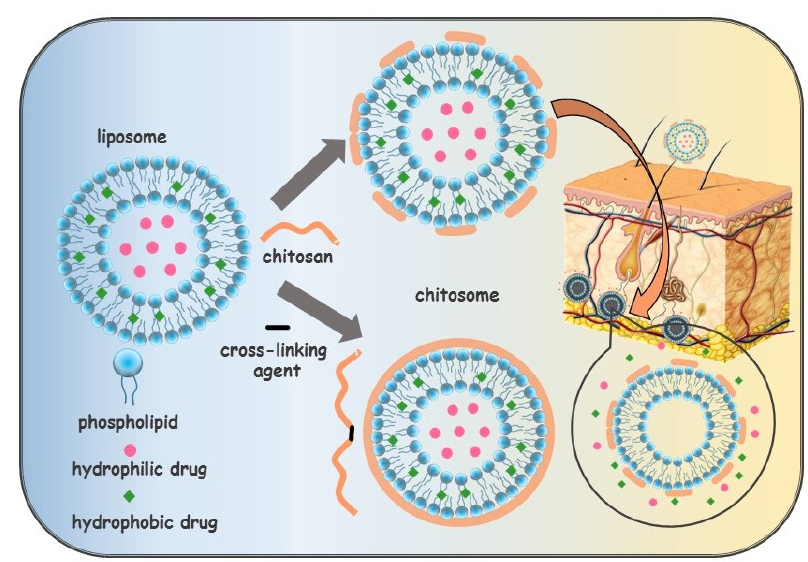
Figure 11. Scheme of obtaining chitosan-coated